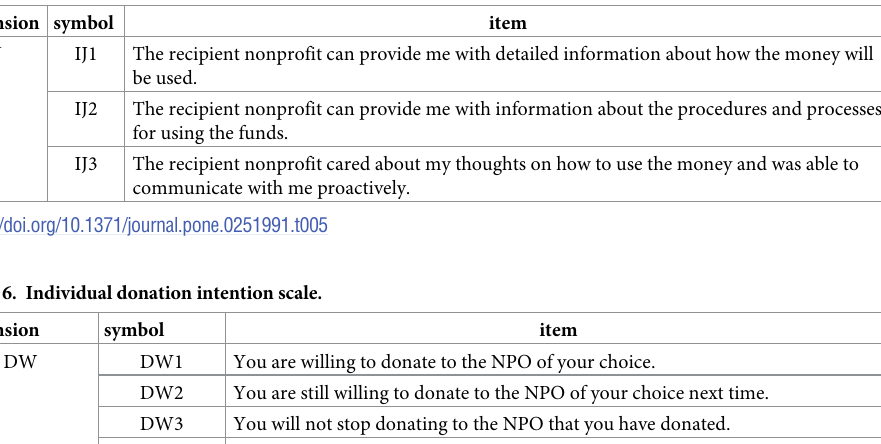
Table 5. Financial information fairness scale.